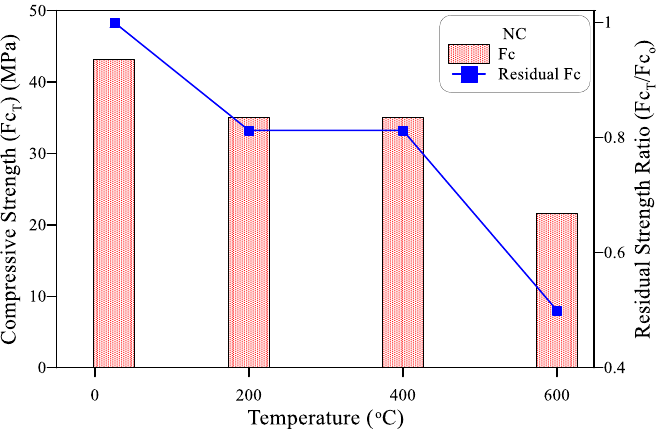
Figure 4. Residual compressive strength of NC at different temperatures.